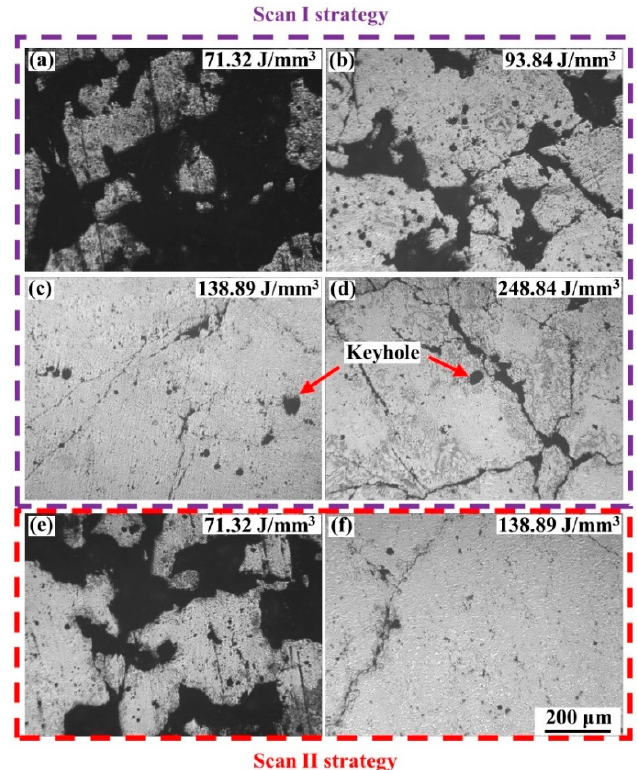
Figure 11. The polished surface of the cemented carbide blocks formed under different laser energy densities: ( a ) 71.32 J/mm 3 Scan I; ( b ) 93.84 J/mm 3 Scan I; ( c ) 138.89 J/mm 3 Scan I; ( d ) 248.84 J/mm 3 Scan I; ( e ) 71.32 J/mm 3 Scan II; ( f ) 138.89 J/mm 3 Scan II. Low energy density would lead to insufficient liquid materials in the molten pools.